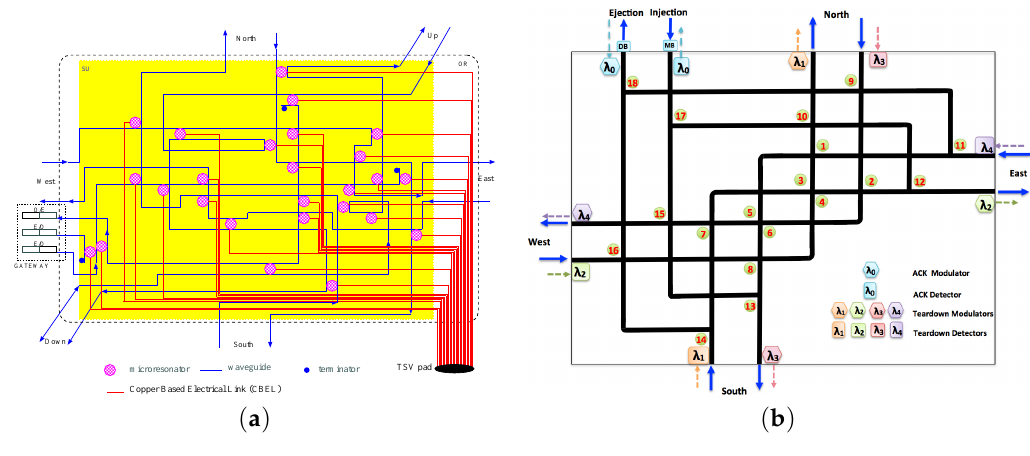
Figure 5. Non-blocking photonic switches: ( a ) 7 × 7 switch; ( b ) 5 × 5